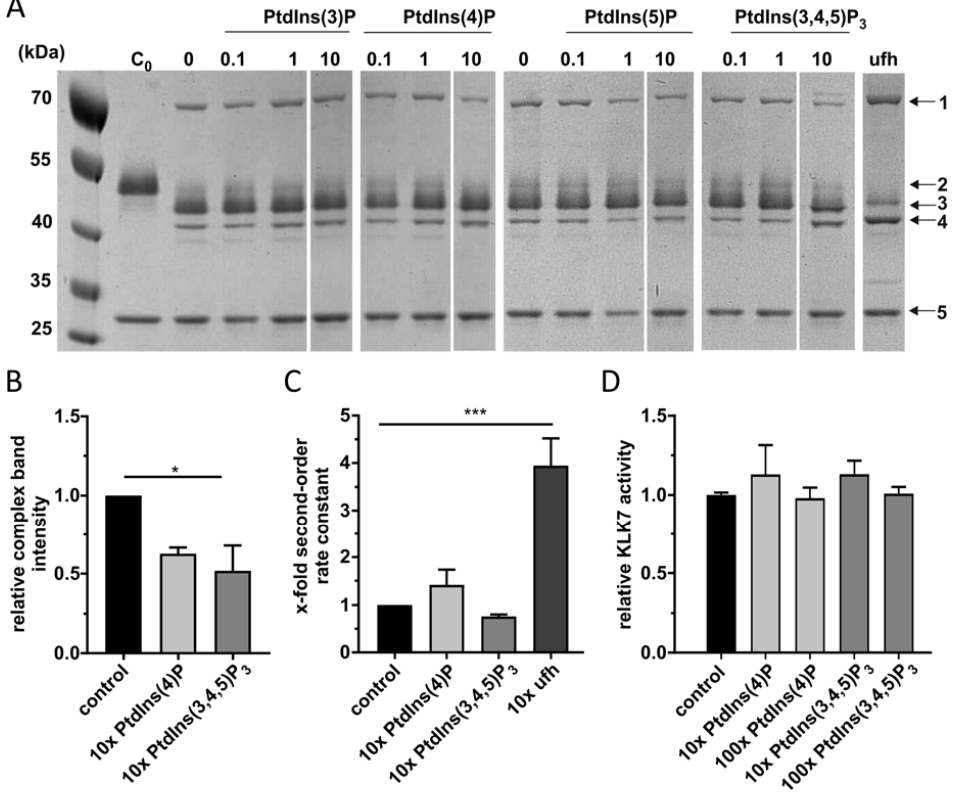
Figure 2. Influence of PtdInsPs on vaspin / KLK7 complex formation and KLK7 activity. ( A ) SDS-PAGE analysis of vaspin / KLK7 complex formation. Vaspin wt was incubated with x-fold excess of PtdInsPs (0.1, 1 and 10-fold) or unfractionated heparin (ufh, 10-fold) as indicated. Notable and indicated bands are: 1-vaspin-protease complex; 2-full-length vaspin; 3- N -terminally cleaved vaspin; 4-RCL- and N -terminally cleaved vaspin; 5-KLK7. KLK7 was incubated with vaspin (at a molar ratio 3:1) for 2 min. C 0 : control reaction after t = 0 min. ( B ) Densitometric quantification of complex formation with and without PtdInsPs or ufh. Presented is the relative increase of complex band intensity as x-fold over control (vaspin without PtdInsP). ( C ) Inhibition of KLK7 by vaspin was measured under pseudo-first-order conditions (ligand / serpin ratio of 10). Presented is the relative increase in second-order rate constant as x-fold over control (without PtdInsP or heparin). ( D ) KLK7 activity was measured in presence of 10 or 100-fold excess of PtdInsPs. Presented is the relative KLK7 activity as x-fold over control (without PtdInsPs). Data are presented as means ± SEM. Statistical significance was determined by one-way ANOVA followed by Dunnett’s post-hoc test. * p < 0.05, *** p <